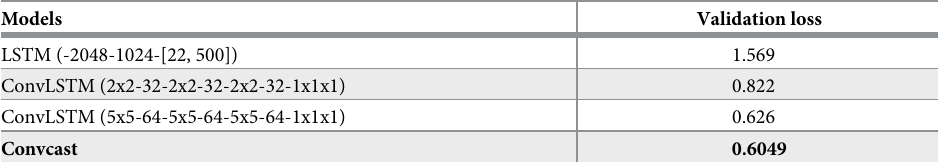
connected layer. ‘2x2’ and ‘5x5’ represent input-to-state kernel size and ‘-2x2’ and ‘-5x5’ represent state-to-state kernel size. ‘-32’ and ‘-64’ are the number of filters in the hidden states of the ConvLSTM layers. ‘-1x1x1’ refers to the 3D convolution.